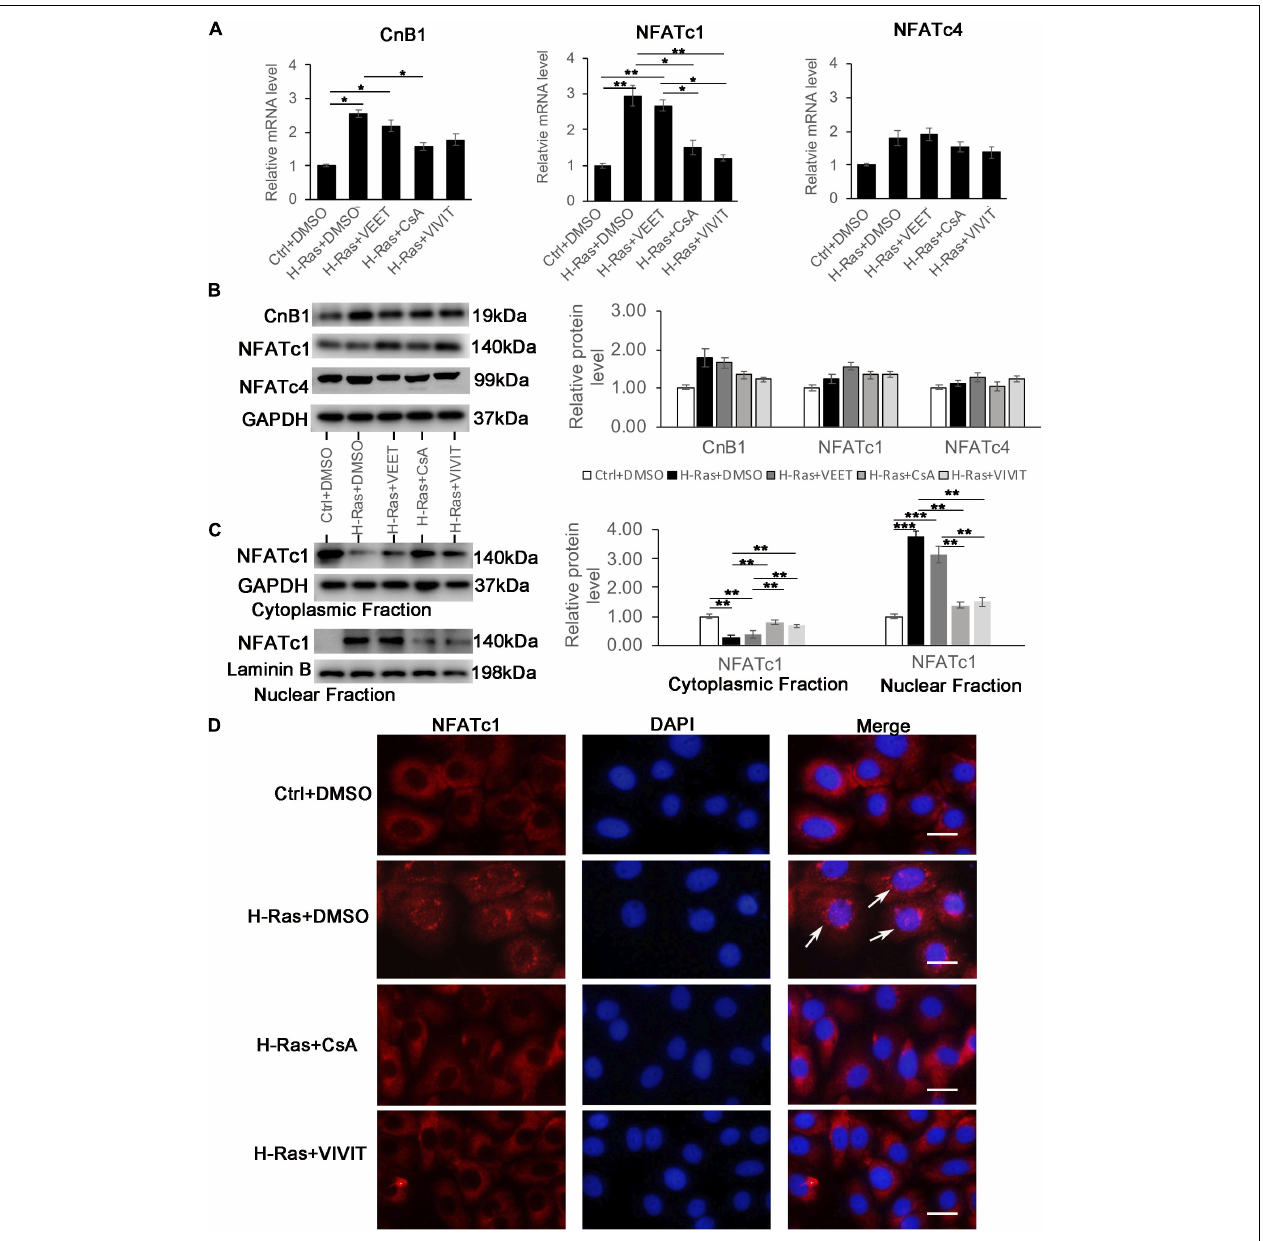
FIGURE 4 | Overexpression of H-Ras induces the nuclear translocation of NFATc1A. Human keratinocytes infected with a H-Ras G 12 V expressing or a control retrovirus were treated with the calcineurin/NFAT inhibitors CsA, VIVIT, VEET as a control peptide for VIVIT or DSMO as negative control for 24 h, after which the cells were collected for quantitative RT-PCR analysis of calcineurin B1 (CnB1), NFATc1, and NFATc4 expression. (B) (Left panel) human keratinocytes were treated with same conditions as shown in (A) , then cells were lysed for immunoblotting analysis of calcineurin B1 (CnB1), NFATc1, and NFATc4 expression, GAPDH as a loading control. (Right panel) Quantification of the relative levels of CnB1, NFATc1 and NFATc4 in the left panel. (C) (Left panel) human keratinocytes treated with same conditions as shown in panel (A) 24 h after infection, the cells were lysed for preparation of cytoplasmic and nuclear fractions. Both fractions were immunoblotted with the NFATc1 antibody, GAPDH as a loading control for the cytoplasmic fraction, and Laminin B as a loading control for the nuclear fraction. Right panel: Quantification of the relative levels of NFATc1 in the left panel. (A–C) All experiments were carried out three times, and error bars represent means + SD; p values are indicated with “*,” * p < 0.05, ** p < 0.01, *** p < 0.005 when comparing two corresponding groups indicated with the black lines by Student’s t -test. (D) Human keratinocytes infected with a H-Ras G 12 V expressing or a control retrovirus treated with the calcineurin/NFAT inhibitors CsA and VIVIT or DMSO as a control for 24 h, followed by immunofluorescence staining with the NAFTc1 antibody (red), and DAPI stain for nuclei. Merged images (Merge) are shown in the right column, and white arrows indicate the nuclear staining of NFATc1. Bars = 50 µ m.